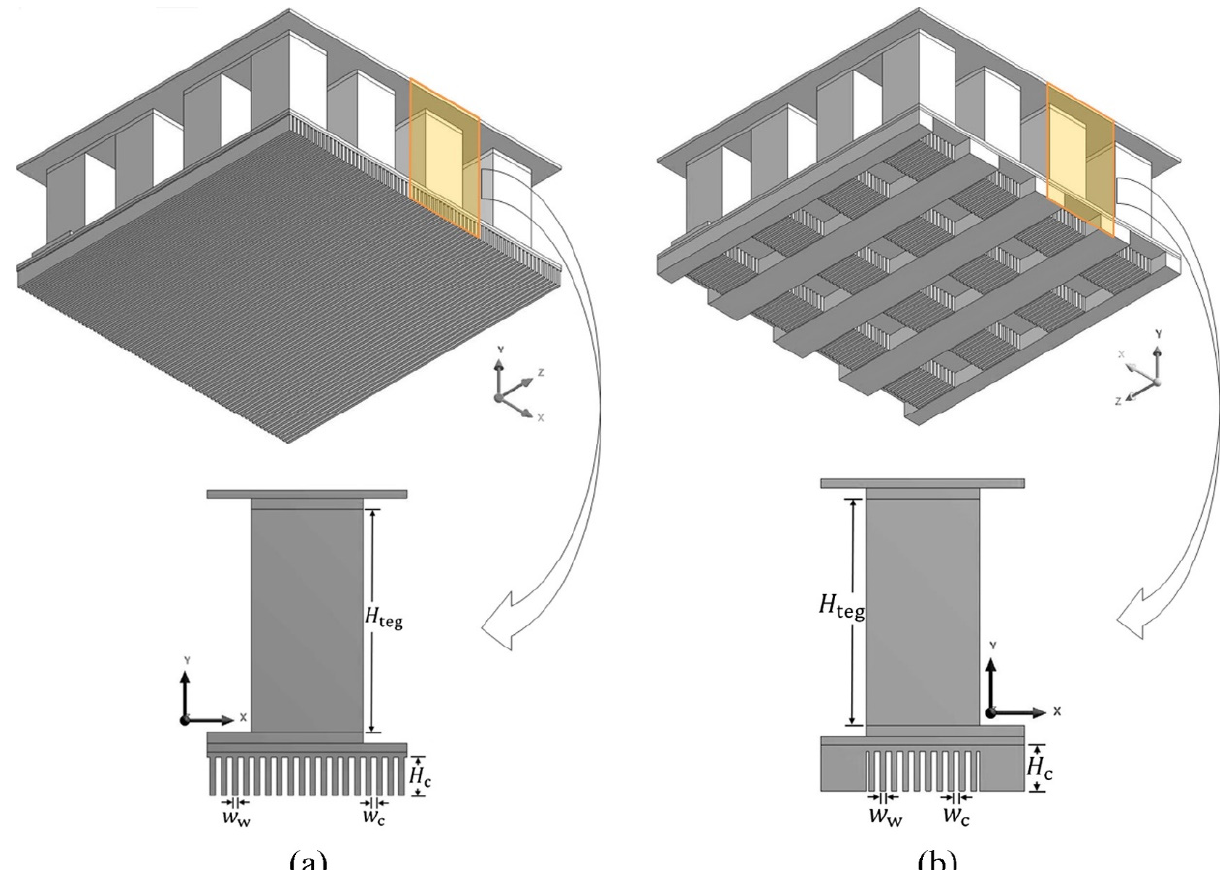
Figure 12. Two different kind of microchannel heat exchanger arrangements: ( a ) plate-fin heat sink; ( b ) cross-cut heat sink. Reprint with permission [79]; Copyright 2021, Elsevier.